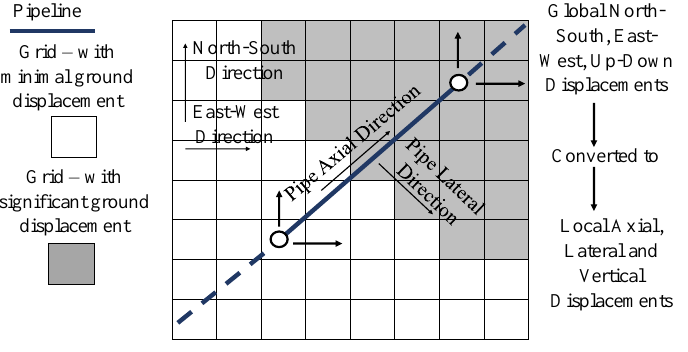
Figure 2. Schematic diagram of FE model displacement boundary condition derivations from probabilistic ground deformation